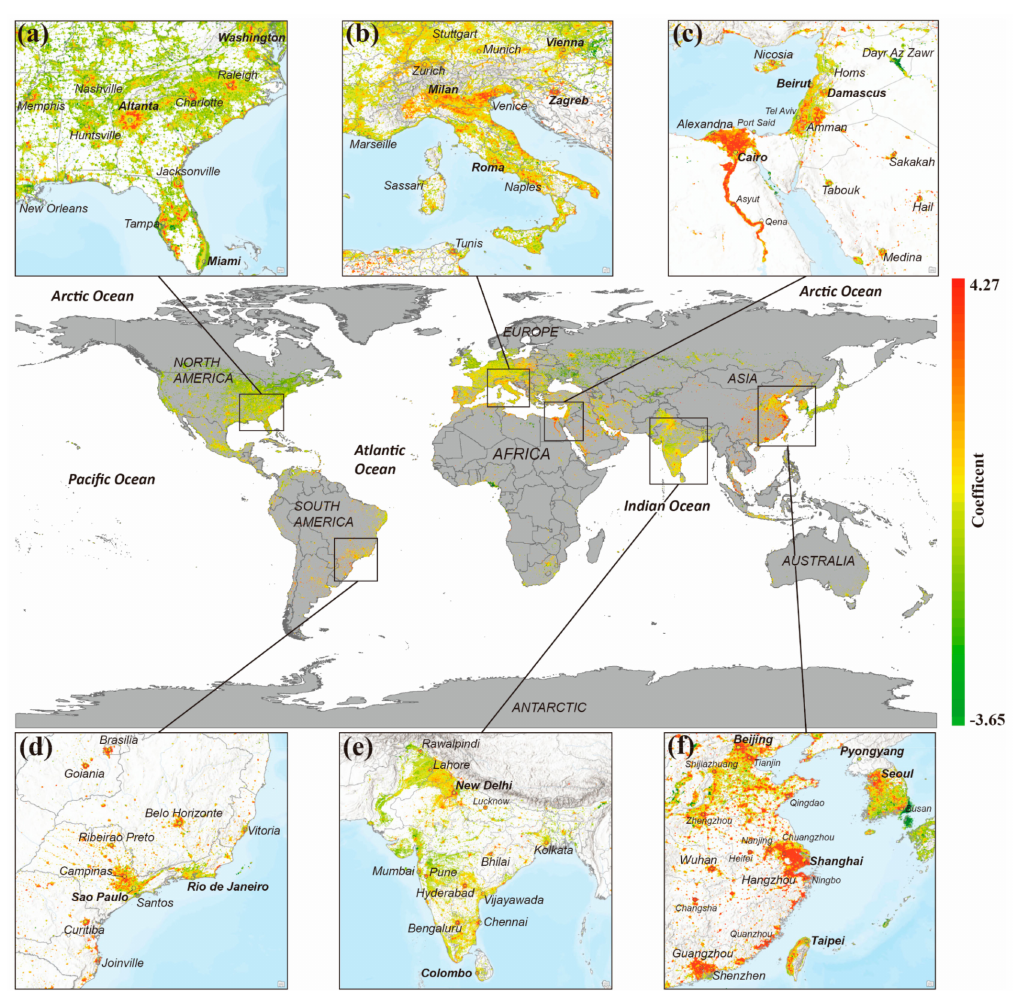
Figure 13. The LICC distribution in typical case areas